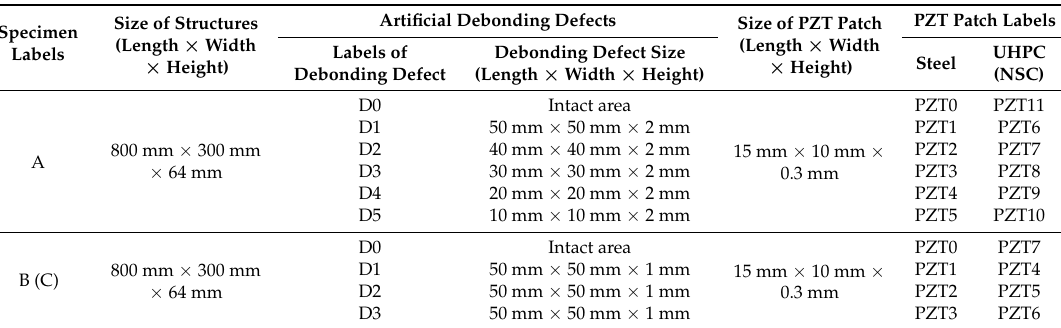
Figure 2. Setup of debonding areas and PZT patches for ( a ) A ‐ type specimen and ( b ) B ‐ type specimen (unit: mm). Table 1. Details of PZT patches and specimen.